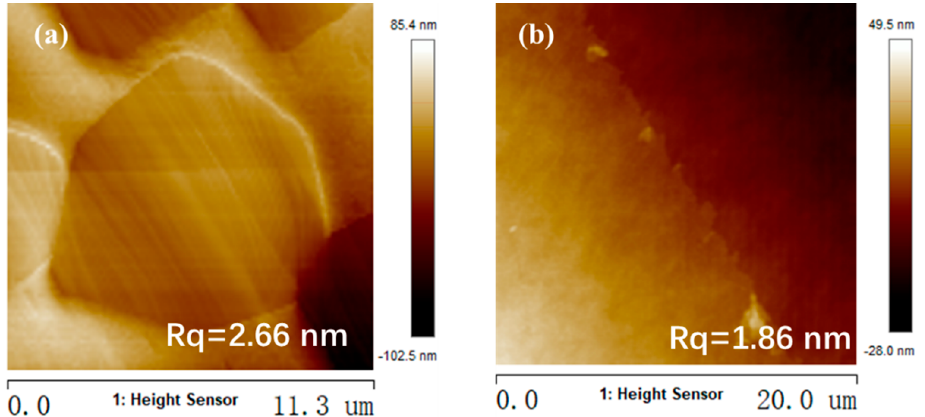
Figure 5. The surface roughness of grown h-BN. ( a ) The roughness of h-BN single crystal, ( b ) the roughness of h-BN thin film.